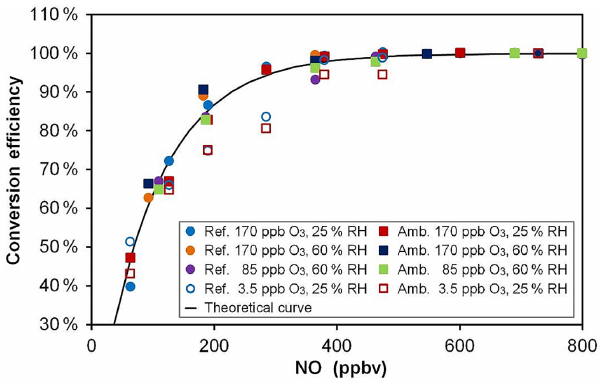
Figure 4. O 3 -to-NO 2 conversion efficiency for various NO mixing ratios, O x levels and relative humidity values. The black curve was calculated from the reaction rate constant between O 3 and NO and a reaction time of 23s. Open symbols (3.5ppbv O 3 ) are hidden be- hind the plain symbols for NO>500ppbv. “Ref.” and “Amb.” refer to the conversion units coupled to the reference and ambient flow tubes,